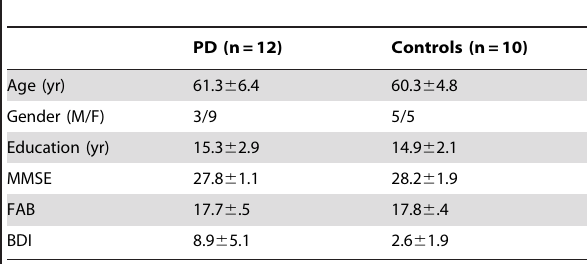
Table 1. Characteristics of PD patients and